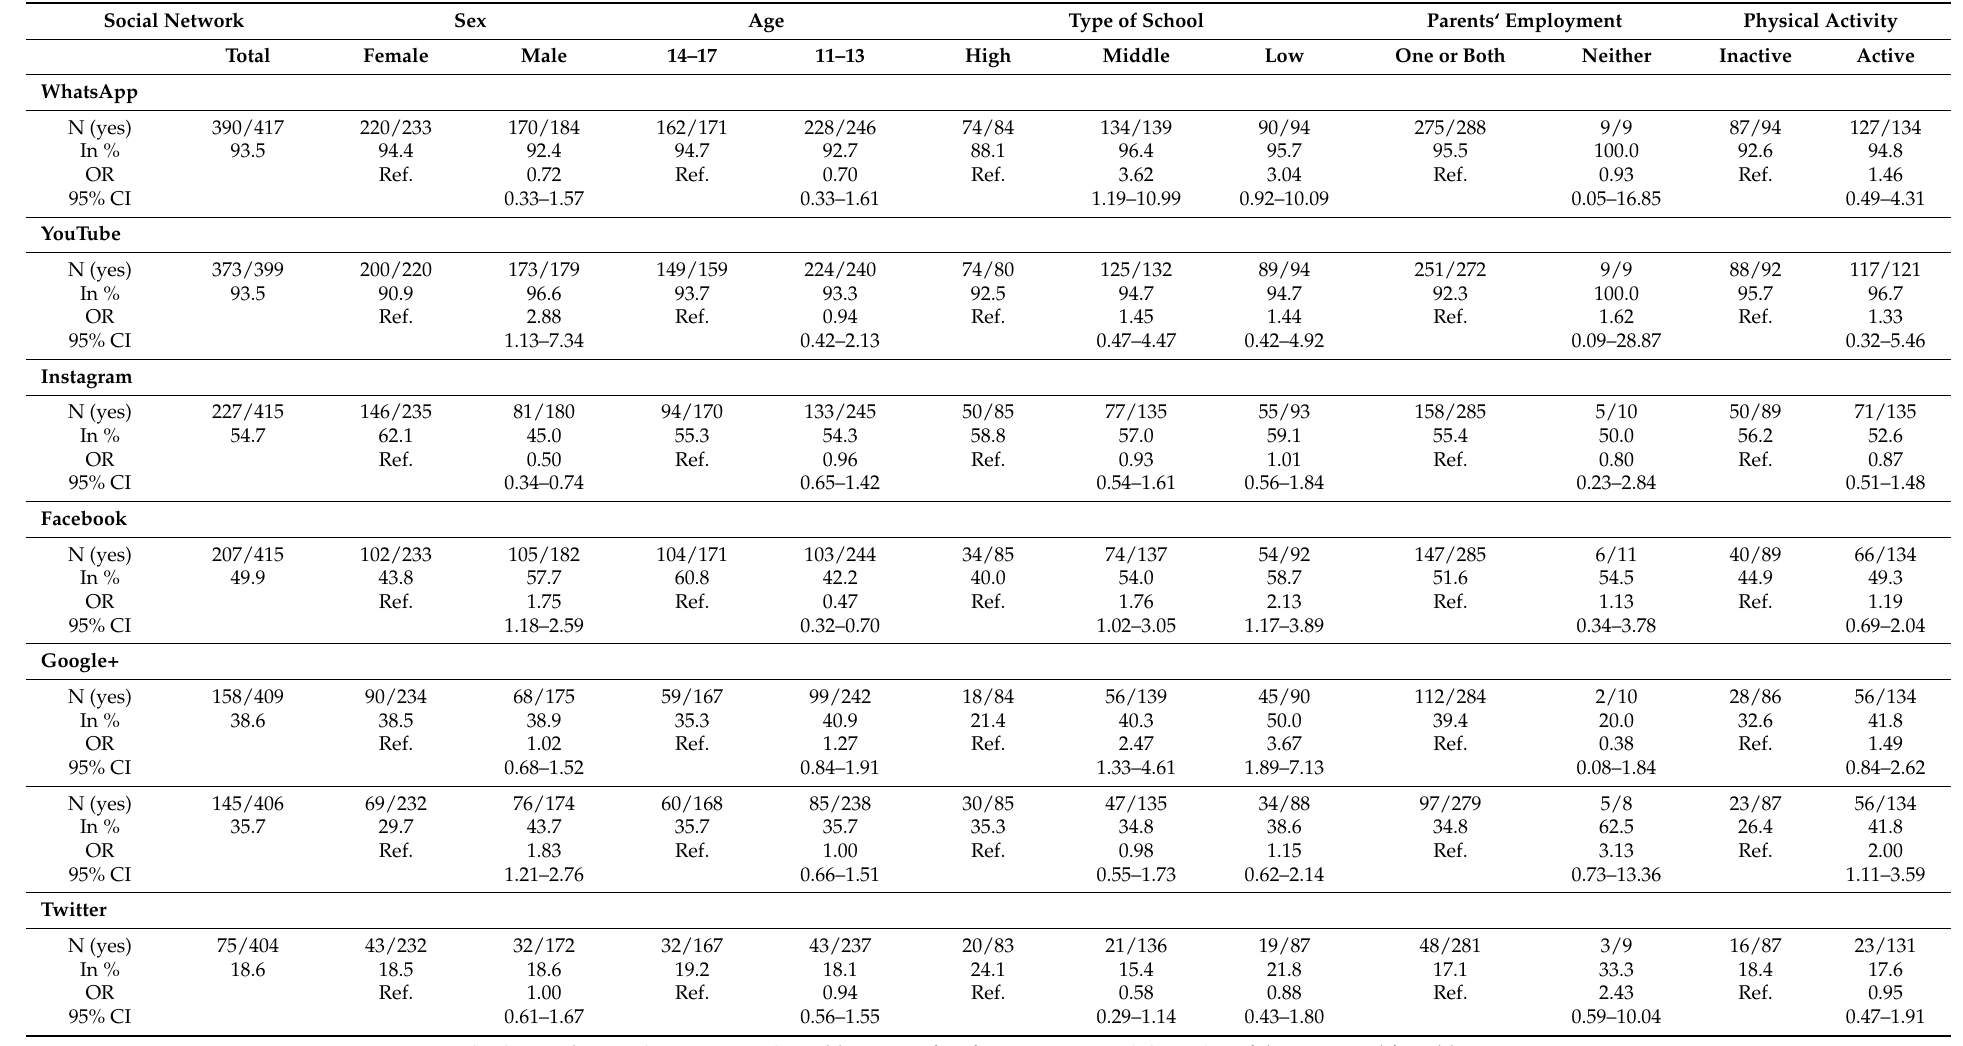
Table 2. Indicators and statistics on social network use by sociodemographic